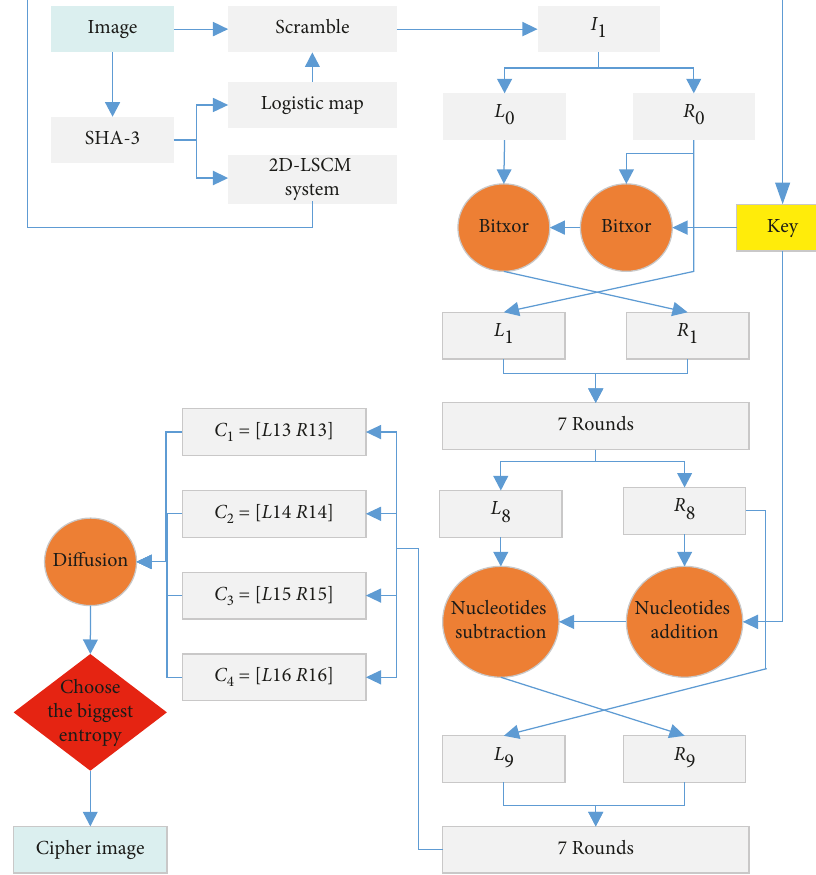
Figure 5: Flow chart of the encryption